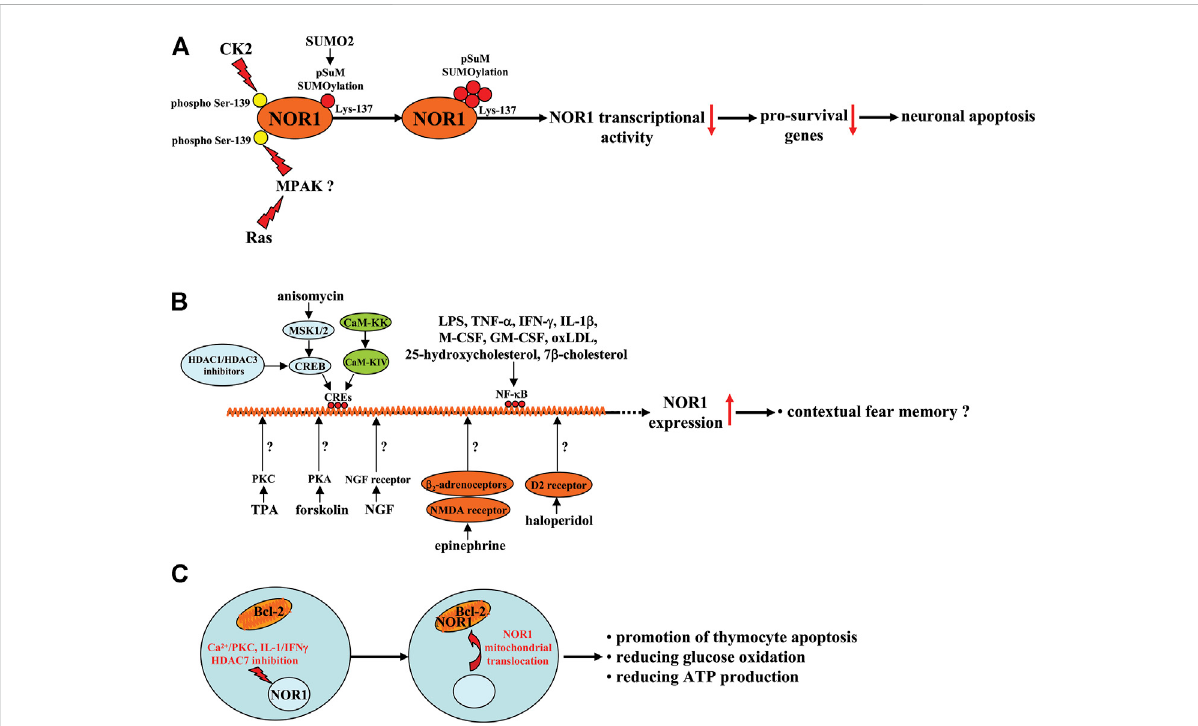
FIGURE 2 A schematic summary of the factors regulating NOR1 expression, function, and subcellular translocation in different cell types. (A) CK2 or Ras- MAPK signaling reduces NOR1 transcriptional activity by increasing SUMO2-mediated pSuM-SUMOlyation of NOR1 in a manner that depends on NOR1 phosphorylation at the Ser-139 site and leads to neuronal apoptosis. (B) Anisomycin-triggered MSK1/2-CREB signaling, CaM-KK-CaM-KIV signaling,andHDAC1orHDAC3inhibitorsmaybindtoCREsintheNOR1promoterandpromoteNOR1transcriptionwithunclearfunctionsora fear memory-promoting effect. Forskolin, TPA, or NGF promote NOR1 transcription by activating PKA, PKC, and the NGF receptors, respectively, although the exact molecular mechanisms are not yet clear. Epinephrine and haloperidol have been shown to increase NOR1 gene transcription probably by mobilizing β 2 -adrenoceptor-NMDA receptor signaling and D2 receptors, respectively. Factors such as LPS, TNF- α , IFN- γ , IL-1 β , M-CSF, GM-CSF, oxLDL, 25-hydroxycholesterol, and 7 β -cholesterol likely increase NOR1 expression through activation of NF- κ B. (C) PKC activation, in combination with Ca 2+ , can induce mitochondrial translocation of NOR1 and exposure of the BH3 domain in Bcl-2, leading to thymocyte apoptosis. In INS cells, the pro-in fl ammatory cytokines IL-1/IFN γ can induce mitochondrial translocation of NOR1 and possible exposure of the BH3 domain in Bcl-2, leading to a decrease in glucose oxidation and ATP production. In thymocytes, when stimulated by signals from the TCR complex, HDAC7 could be phosphorylated and exported from the nucleus, promoting thymocyte